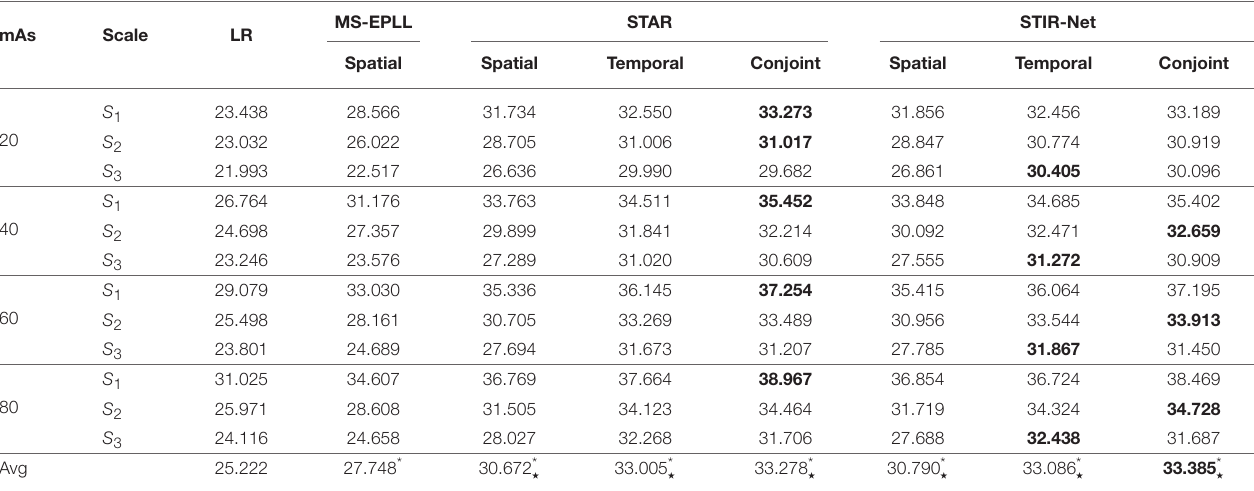
TABLE 3 | Average PSNR comparison of seven patients’ 833 CTP slices for different conditions.